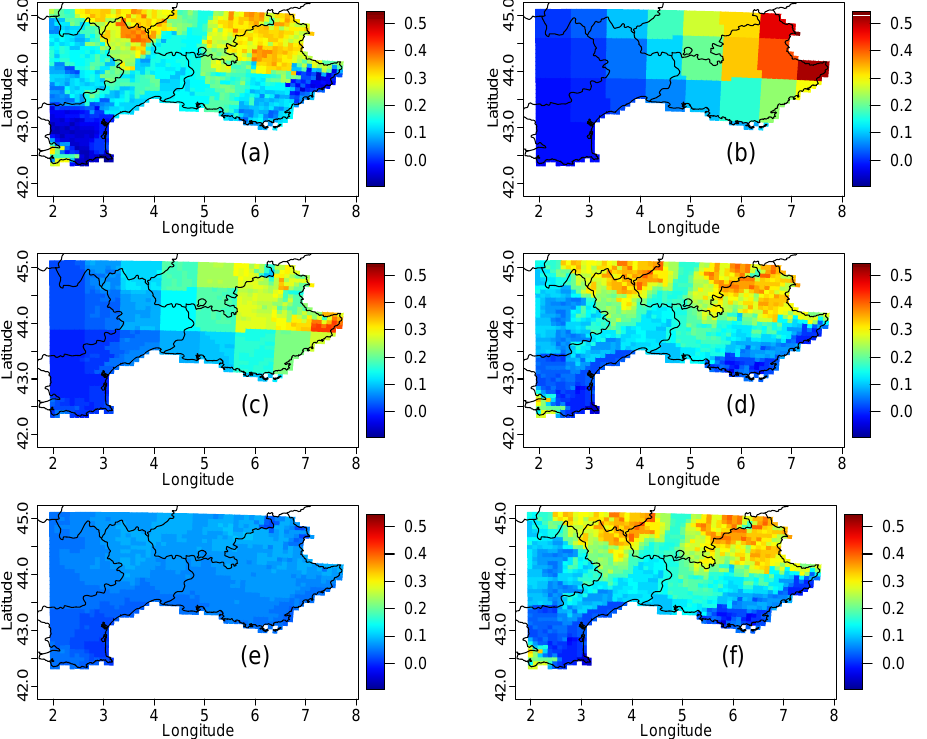
Figure 1. Inter-variable Spearman correlation maps in winter over the evaluation period from: (a) SAFRAN; (b) ERA-I; (c) 1d-BC (CDF-t); (d) 2d-R 2 D 2 ; (e) 1506d-R 2 D 2 on temperature and 1506d-R 2 D 2 on precipitation; (f) 3012d-R 2 D 2 .